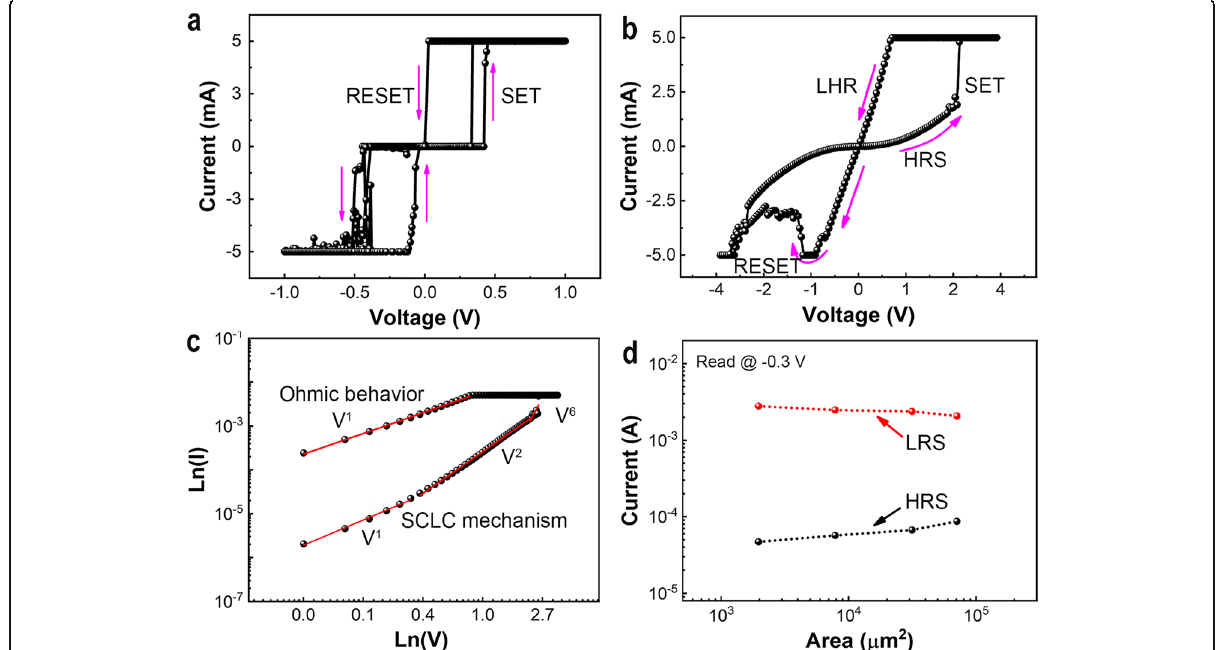
Fig. 3 Conduction mechanism analysis of Ag/SiO x :Ag/p ++ -Si and Ag/SiO x :Ag/TiO x /p ++ -Si devices. a The linear I – V curve of Ag/SiO x :Ag/p ++ -Si and b Ag/SiO x :Ag/TiO x /p ++ -Si device. c The conduction mechanisms correspond to SCLC at HRS and Ohmic at LRS for the Ag/SiO x :Ag/TiO x /p ++ -Si device according to the fitting results of the positive region of I – V curve in ( b ). d Cell area dependence of the conductance at the LRS or the HRS